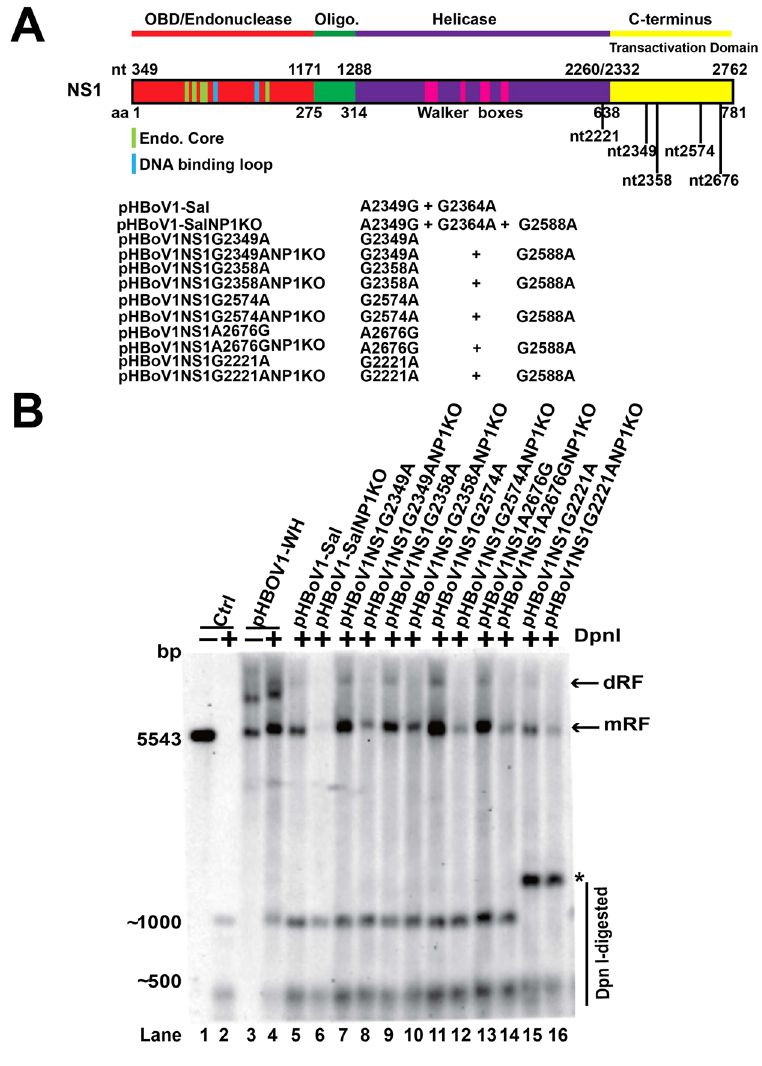
Figure 3. Mutations in the C-terminus of NS1 ORF affected NP1 function. ( A ) Diagram of NS1 ORF and NS1 mutated plasmids. NS1 ORF is presented with different functional domains, highlighting the nucleotide and amino acid position with numbers. Plasmids with mutations in the NS1 region from clinical samples or reports with or without NP1 knockout are shown. ( B ) Southern blot analysis. Plasmids in panel A were transfected into HEK293T cells. Low-molecular-weight DNA samples were harvested 48 h post-transfection. Southern blots were performed after Dpn I digestion and the signal was detected by ChemiDoc TM MP imaging system. The size of Dpn I digested bands in lanes 15 and 16 is bigger because the Dpn I enzyme sites